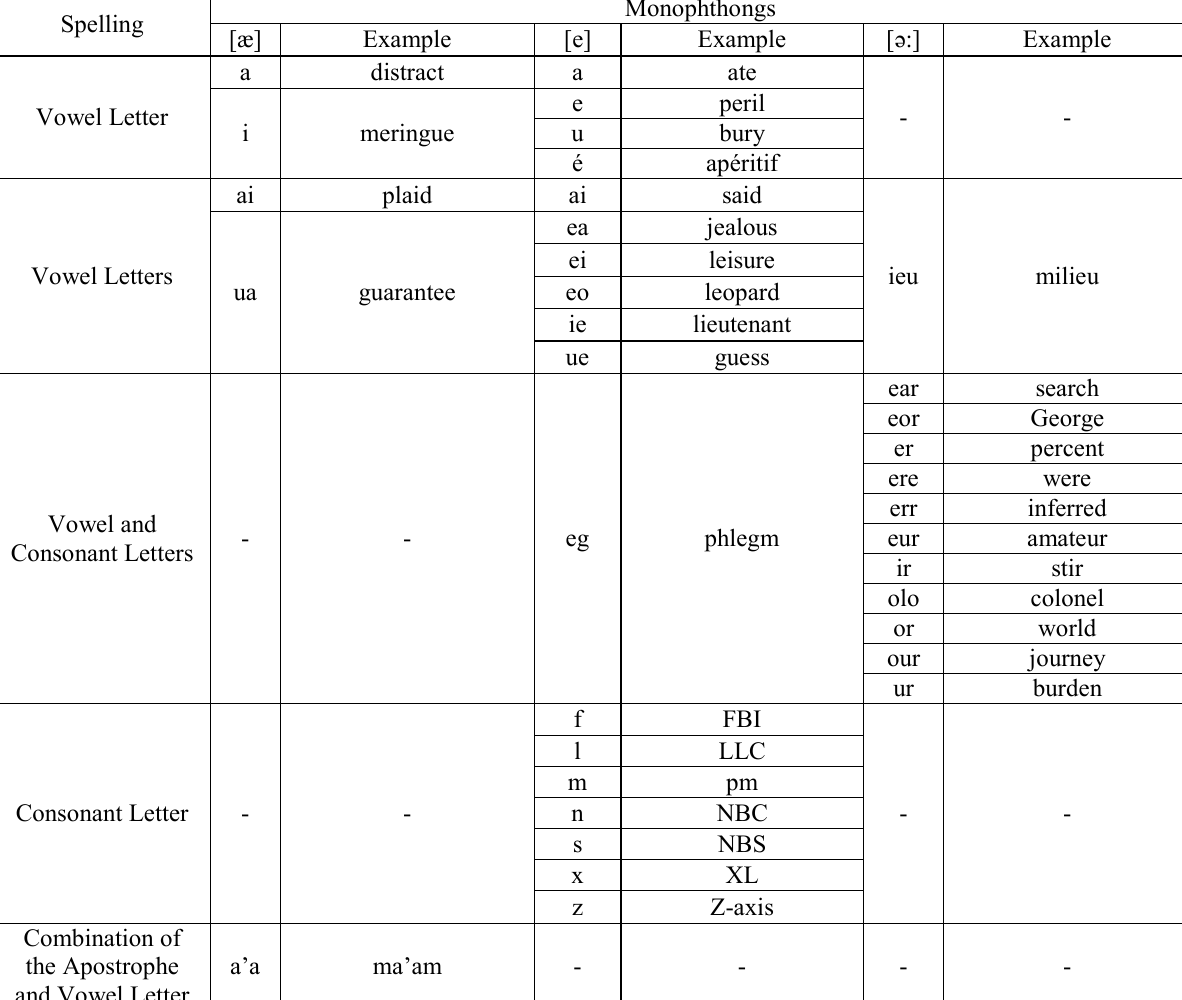
Table 3. Ways of Graphical Spelling of Monophthongs [æ], [e] and [ ə